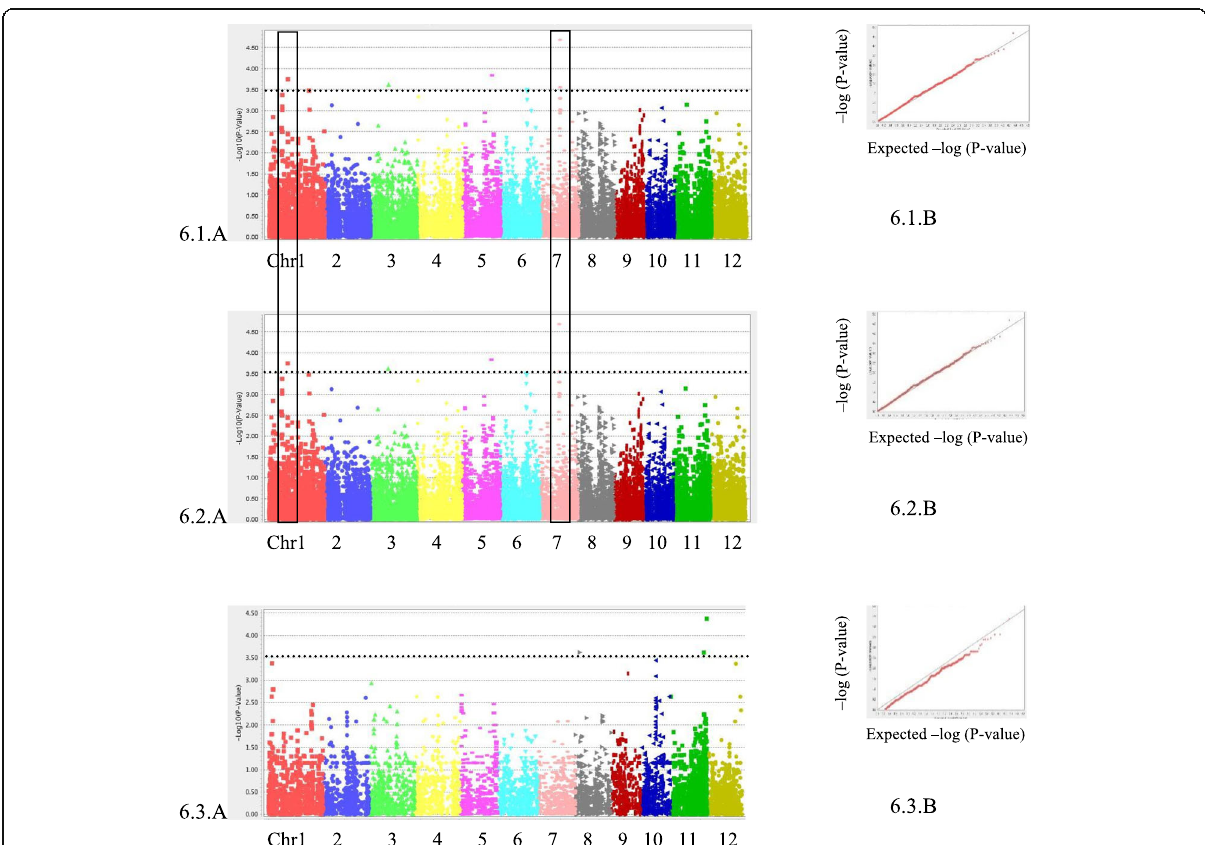
Fig. 6 GWAS for the effects of exogenous JA on RTW. Manhattan plot ( a ) and Quantile-quantile plot ( b ) for root weight in a whole (6.1) panel or Indica (6.2) or Japonica (6.3) subpanel. The black line indicates the suggestive significance threshold, p =